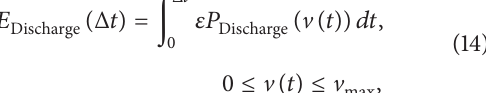
Figure 5: Distribution of the trip